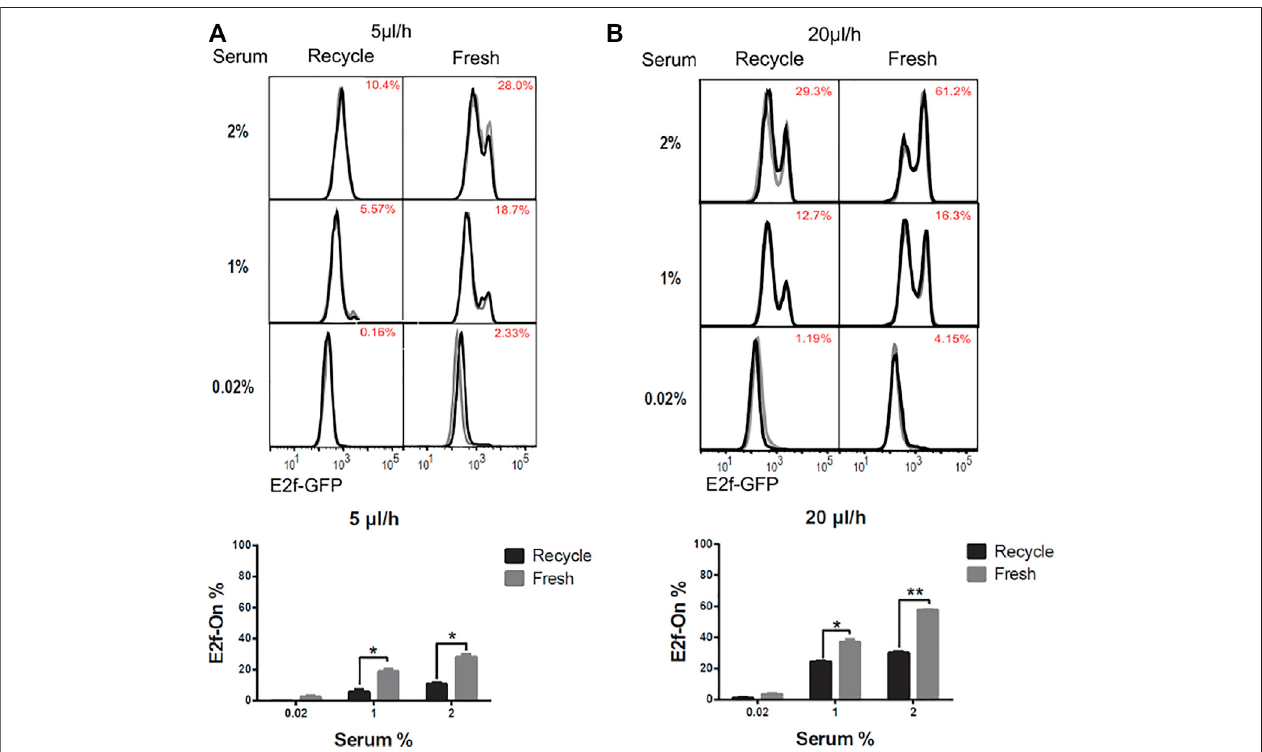
FIGURE 5 | Extracellular factor replacement drive cells to shallow quiescence. REF/E23 cells seeded in micro fl uidic devices were induced to and maintained in quiescencebyculturingtheminserum-starvationmediumfor4 daysunderthe fl owratesof5 μ l/h (A) and20 μ l/h (B) .Duringthisperiod,the fl owdirectionwasswitched every 24 h, after a complete volume of medium ( V = 120 and 480 μ l, respectively, for r = 5 and 20 μ l/h) passed through the microchannel; the previous medium ( “ recycled ” ) or a fresh medium ( “ fresh ” ) of volume V was used to continue the fl ow experiment in the micro fl uidic device. Cells were subsequently stimulated with serum at the indicated concentrations for 26 h, and the E2f-On% were assayed. (Top) E2f-GFP histograms with red numbers indicating the average E2f-On% from duplicate samples (black and grey). (Bottom) Statistic bar chart of the E2f-On% in cell populations (from the top) as a function of extracellular fl uid replacement con fi guration (in serum-starvation) and serum concentration (in serum-stimulation). Error bars, SEM ( n = 2), * p < 0.05, ** p < 0.01.